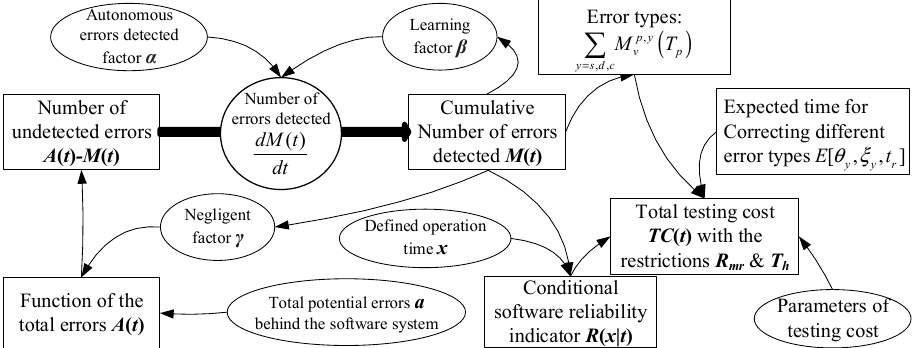
Figure 1. Causal loop diagram of the proposed model.